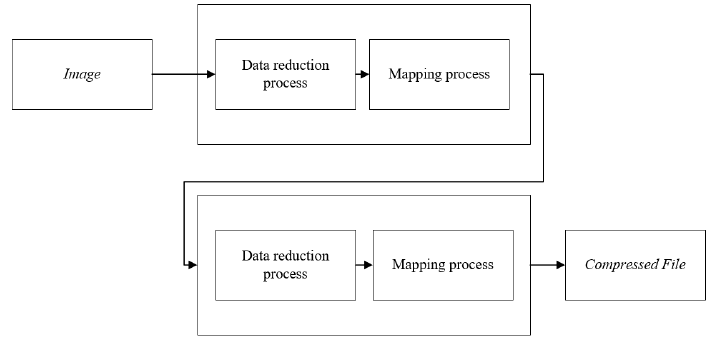
Figure 6. Compression stages.